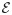
Evolution of world economic production Y in trillion 2010 USD per year (solid line) and the integrated contribution to the world cumulative production W in trillion 2010 USD proportional to the shaded area under the curve.The period between 1980 to 2017 that is used for comparison with world primary energy consumption E as described in the text is delineated by the dashed line and shown by the gray arrow.